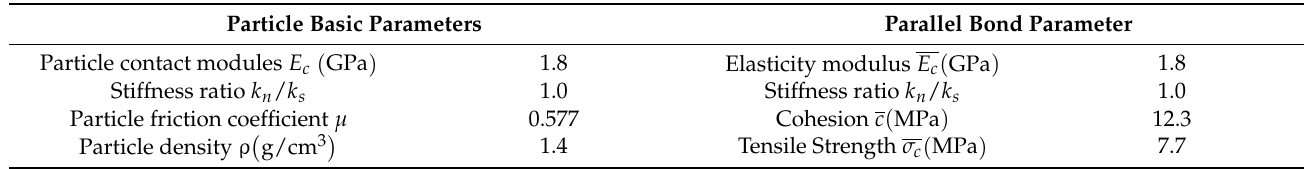
Figure 3. Experimental results of coal sample subject to uniaxial compression. Table 1. Mesoscopic parameters of the numerical specimens.